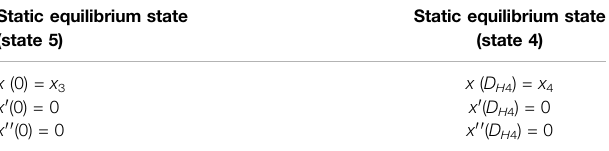
TABLE 10 | Return phase conditions (horizontal